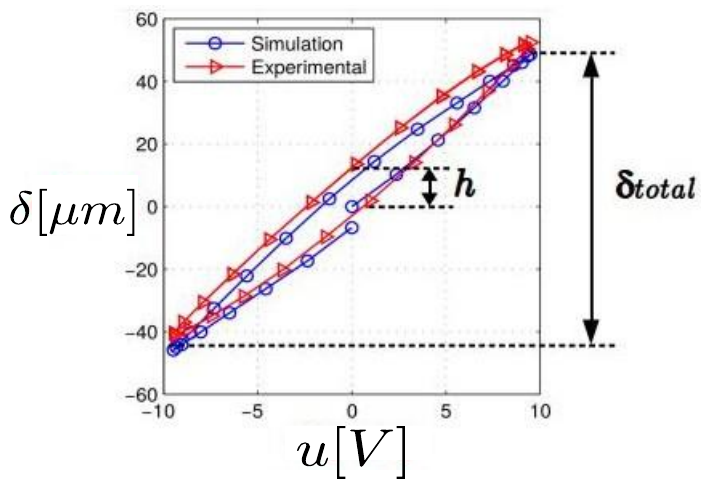
Figure 2. Curve depicting the non-linear displacement behavior of a